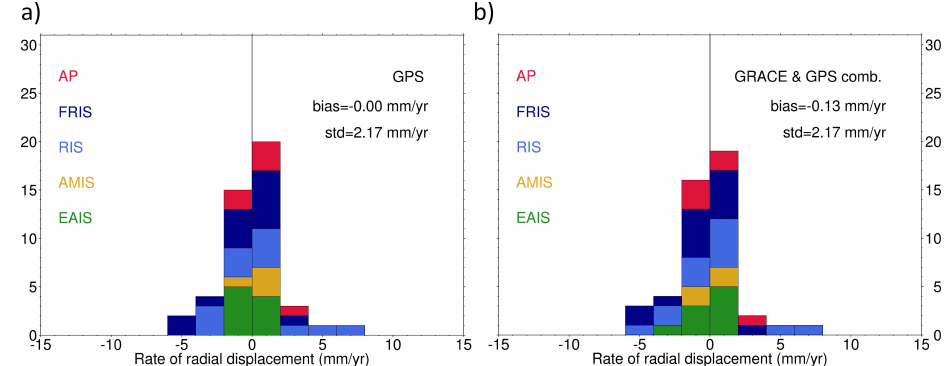
Fig. 3. Observed minus predicted rate of surface deformation at GPS sites. Shown are the residuals in GPS-measured (mean of InSAR and ICESat-based elastic and Northern Hemisphere GIA correction applied) minus GIA estimated uplift rates, based on GPS (left) and GRACE and GPS observations (right). Residuals < 0 ( > 0) indicate overestimated (underestimated) GIA with respect to the GPS uplift rates. The residuals are separated for each sector: Antarctic Peninsula (AP, red), Filchner-Ronne Ice Shelf (FRIS, dark blue), Ronne Ice Shelf (RIS, light blue) and Amery Ice Shelf (AMIS, yellow), and the remaining parts as East Antarctica (EAIS, green). Also indicated are the mean bias (bias, not weighted), as well as the standard deviation (std, not